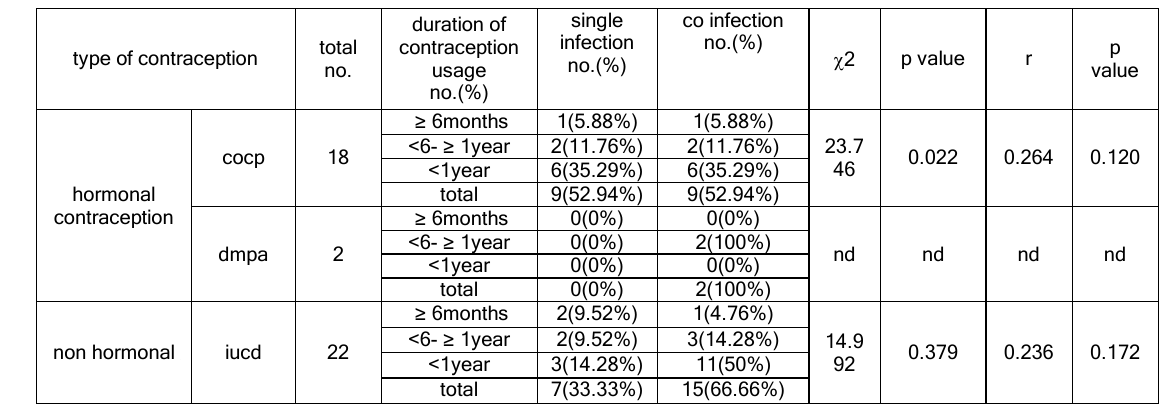
Table (5): Types of infection and related with type of contraception and duration of usage